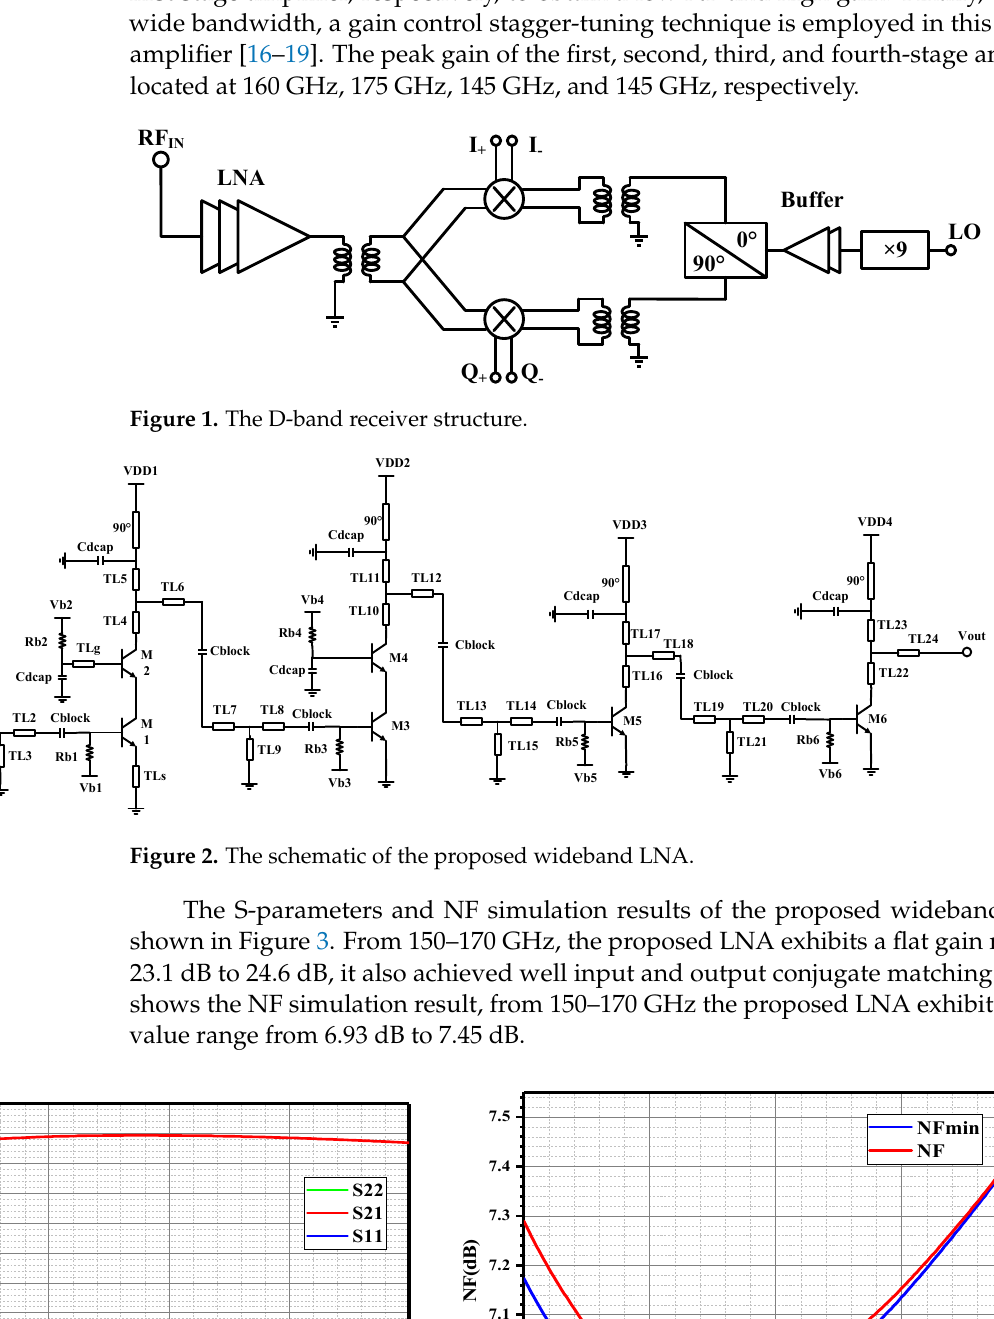
Figure 4. The schematic of the down-conversion mixer. The pseudo-differential transconductance stage eliminates the linearity penalty caused by the tail-current source. As a down conversation mixer, the inductive emitter degeneration technique is employed at high frequency for enhancing linearity. The size of the transconductance stage was determined as minimum as possible to provide a high input impedance to relieve the stress of impedance matching. The size of the switching quad was also determined as a minimum to relax the LO requirement [20]. The mixer drives a 500 Ω load, a relatively large load that provides high voltage gain. Simulating the conversion gain, the S-parameter quadrature mixer results are shown in Figure 5.